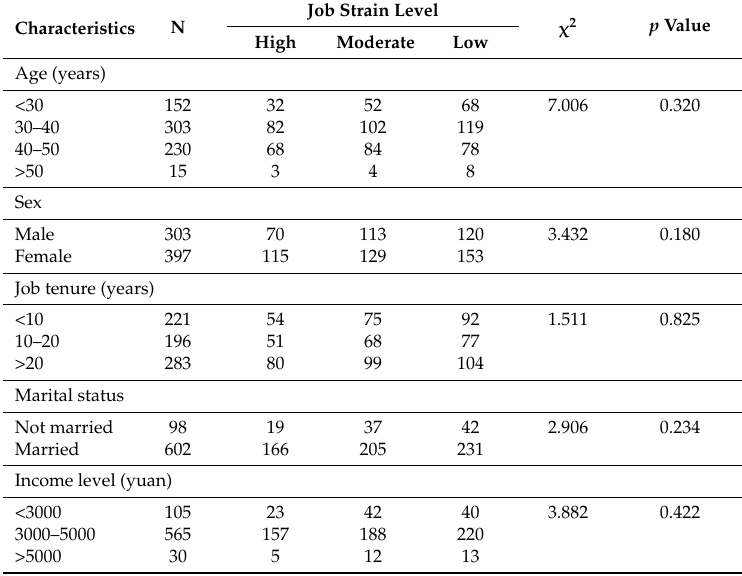
Table 1. Job strain groups according to subject characteristics.